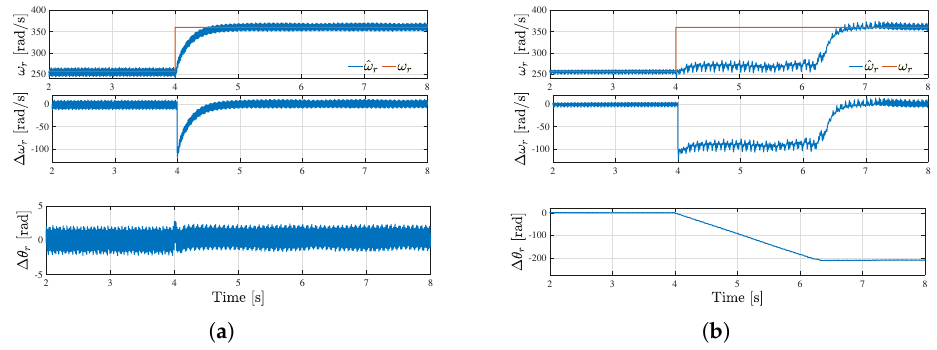
Figure 8. Simulation results during a step change in the active stator power. ( a ) Simulations results from the proposed SMC-MRAS estimator and ( b ) simulations results from the PI-MRAS estimator.